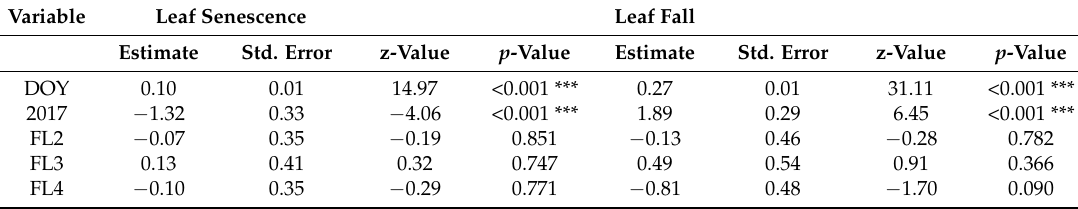
Table 5. Model statistics for the timing of leaf senescence and leaf fall. The provenance FL1 and the year 2016 are the standard levels for the categorical variables provenance and year, to which the other year, 2017, and the other provenances are compared. Provenance abbreviations are given in Table 1. Variable Leaf Senescence Leaf Fall Estimate Std.